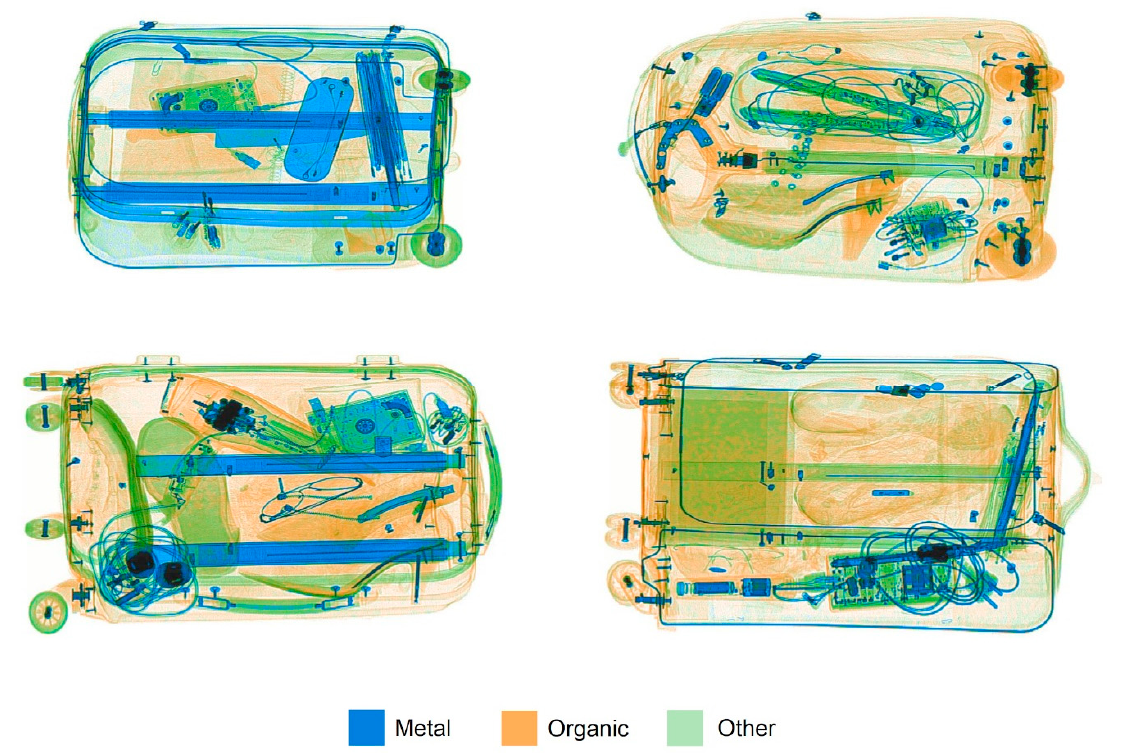
Figure 1. Example X-ray images of bags, two contain threats (top left—knife; bottom right–pistol); images from the CaSePIX image library [1]. Reproduced with permission from the copyright holder Dr Greg Davis.